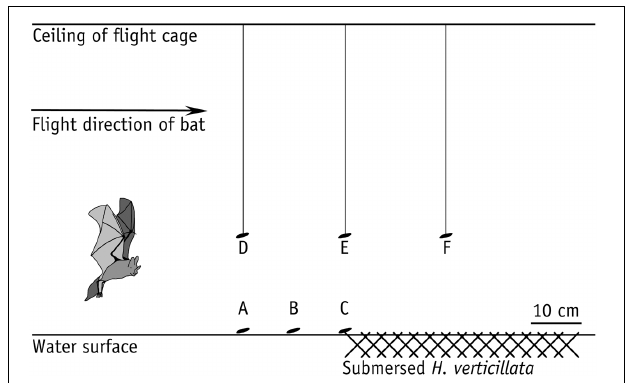
FIGURE 1 | Array of clutter experiments in the flight cage on BCI, Panamá, with M. macrophyllum searching for mealworms offered on the water surface (a–c) or tethered on a nylon thread (d–f) at different distances to horizontal clutter produced by leaves of H. verticillata water plants floating on the water